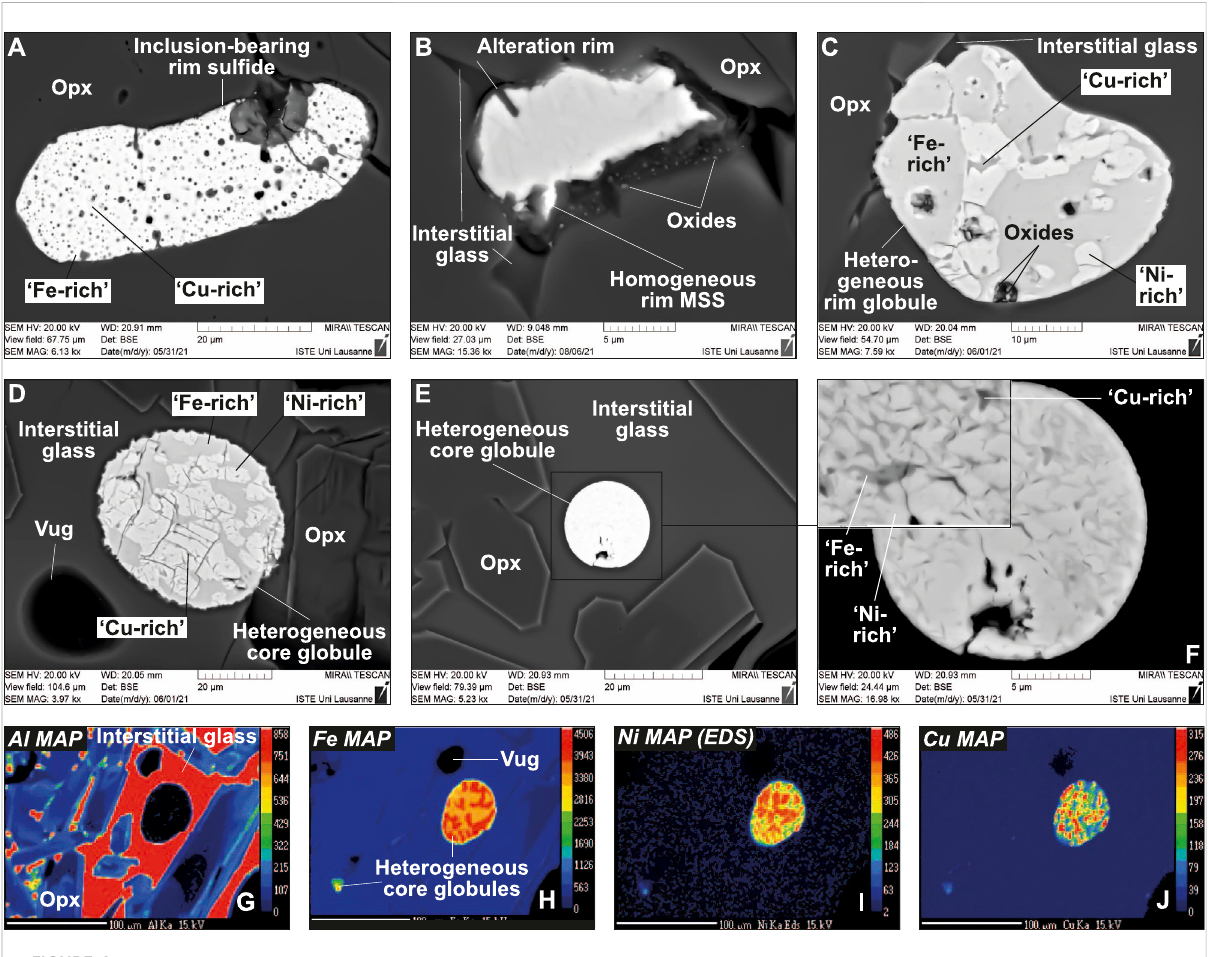
FIGURE 4 Textural features of sul fi des (all MSS or “ xSS ” ) in the glass-bearing, Type 1A vein from West Bismarck. (A – F) BSE images (SEM) and (G – J) major element maps (EPMA) for vein core sul fi des. Scale bar is 100 μ m in (G – J) , whereas the elements mapped are indicated in the top left corners of the images. Note the homogeneity of some rim MSS, whereas all core globules are